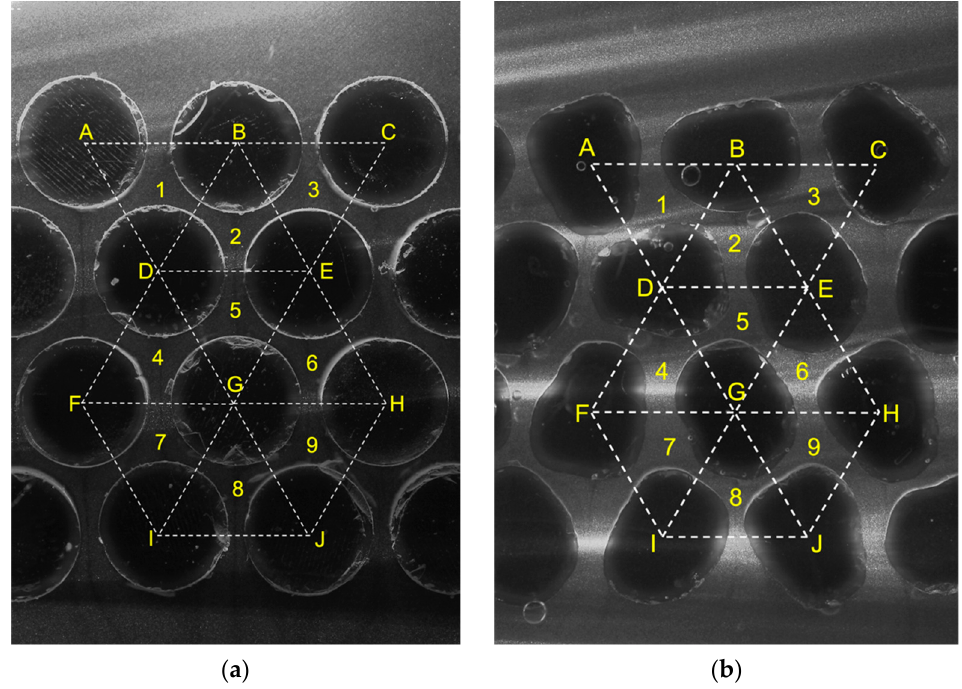
Figure 9. Typical flow images captured by the high-speed camera for ( a ) cylindrical particles and